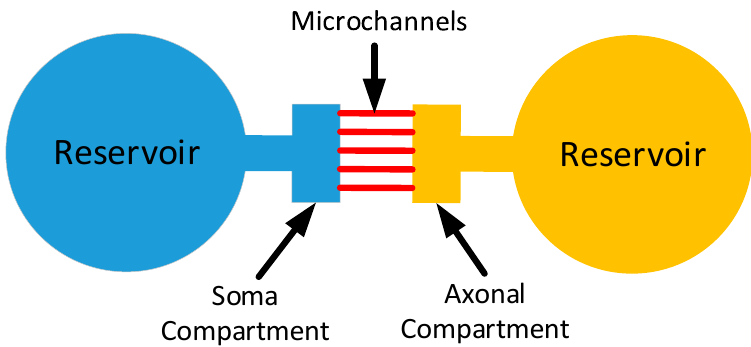
Figure 1. A basic structure of microfluidic device for neuron regeneration.